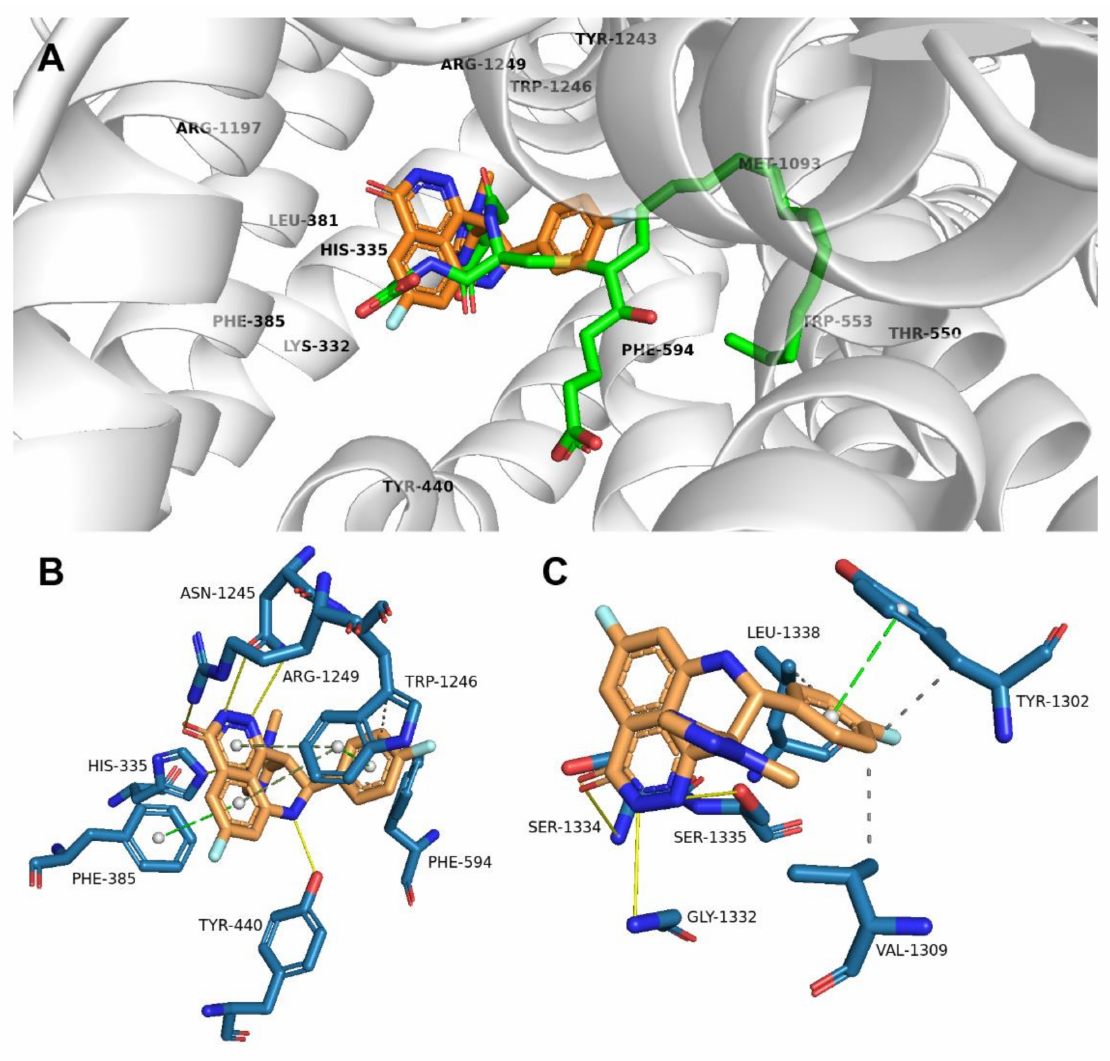
Figure 4. ( A ) Orientation of talazoparib relative to LTC4 (green sticks) in the ABCC1 transporter. ( B ) ABCC1 residues (blue sticks) predicted to interact with talazoparib. ( C ) Predicted interactions of talazoparib with ABCC1 (cid:48) s NBD2. Residues surrounding P- and H-pocket are shown as labels. H-bonds are shown as yellow lines, π -stacking as green-dashed lines, and hydrophobic interactions as gray-dashed